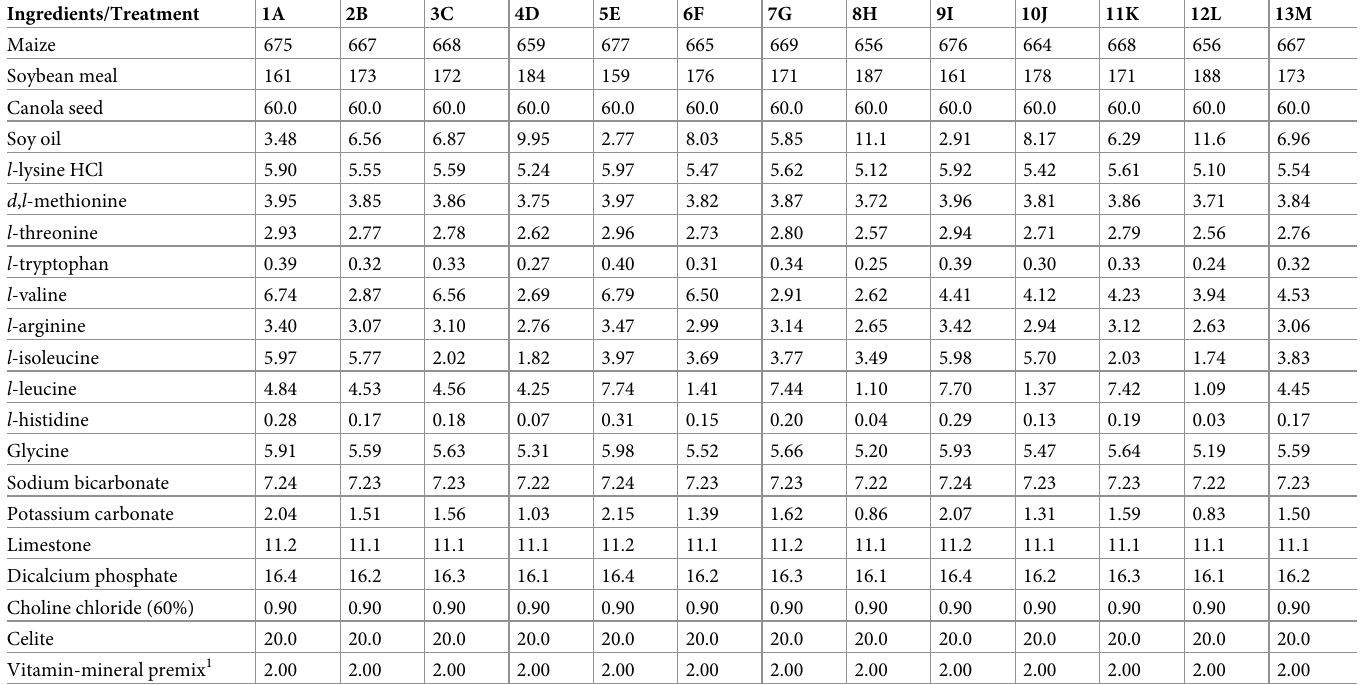
Table 3. Composition of experimental diets (g/kg). Ingredients/Treatment Soybean